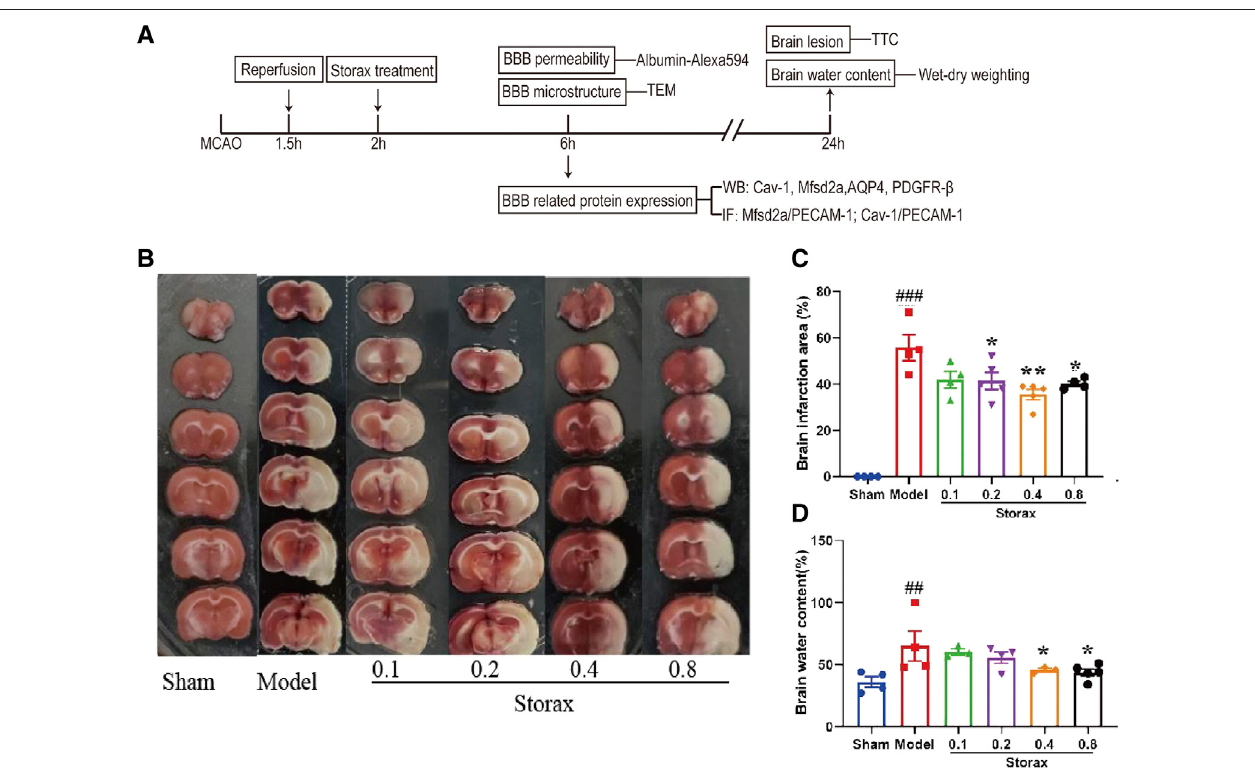
FIGURE 1 | Storax decreases infarction size and brain water content at 24 h after stroke. (A) Schematic diagram of experimental design. MCAO: middle cerebral artery occlusion; TEM: transmission electron microscope; BBB: blood-brain barrier; IF: immunohistochemistry fl uorescence; TTC: 2,3,5-triphenyltetrazolium chloride; (B) Representative images of TTC staining. (C) Quanti fi cation of the brain infarction area. (D) Quanti fi cation of the brain water content. Data were shown as the mean ± SEM. ## p < 0.01, ### p < 0.001 vs . Control group, * p < 0.05, ** p < 0.01 vs . Storax group, n =